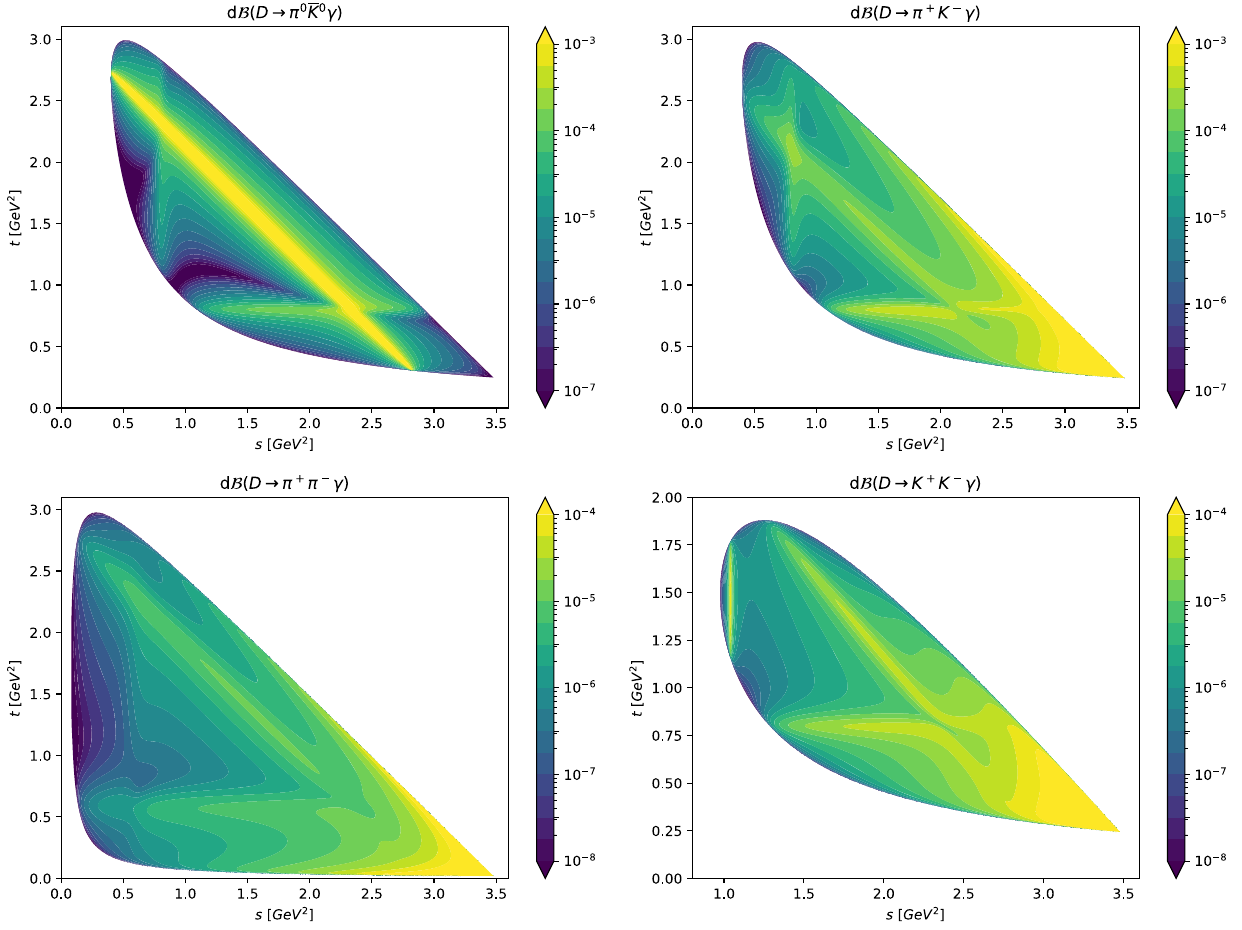
Fig. 2 SM Dalitz plots for the decays D → K 0 π 0 γ (upper left), D → K − π + γ (upper right), D → π + π − γ (lower left) and D → K + K − γ (lower right) based on HH χ PT at μ c = m